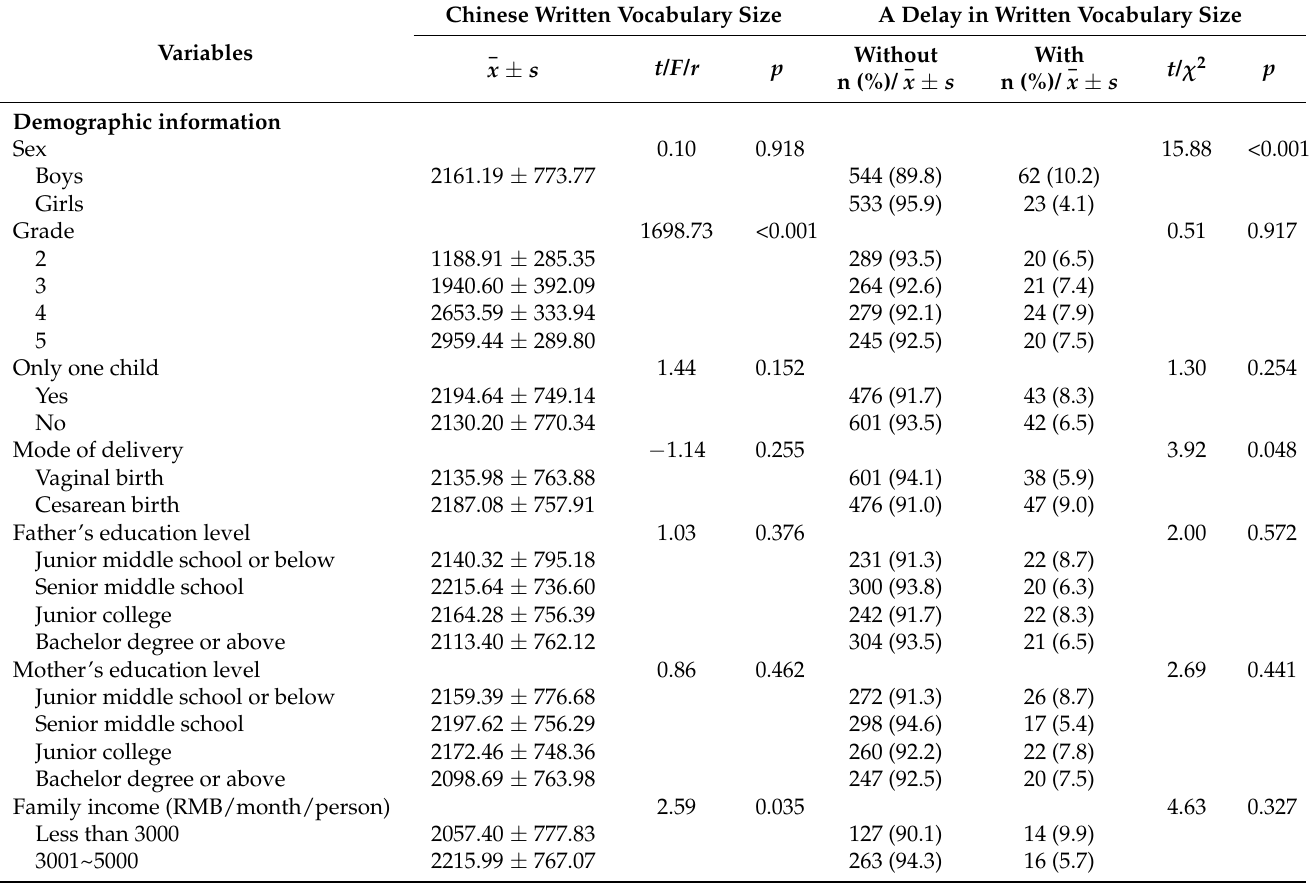
Table 2. Univariate analysis for related factors of Chinese written vocabulary size (N =